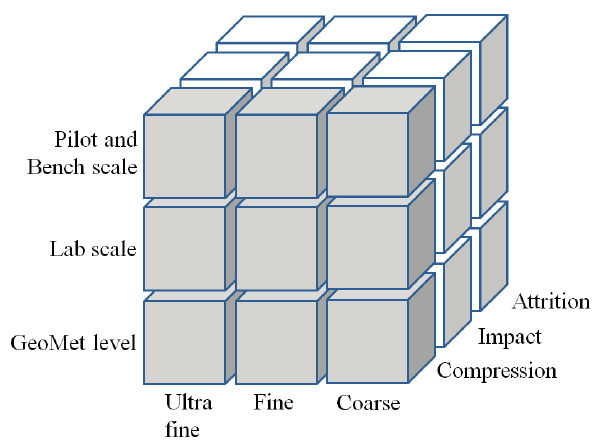
Figure 1. Dimensions in test categorization (GeoMet level = geometallurgical